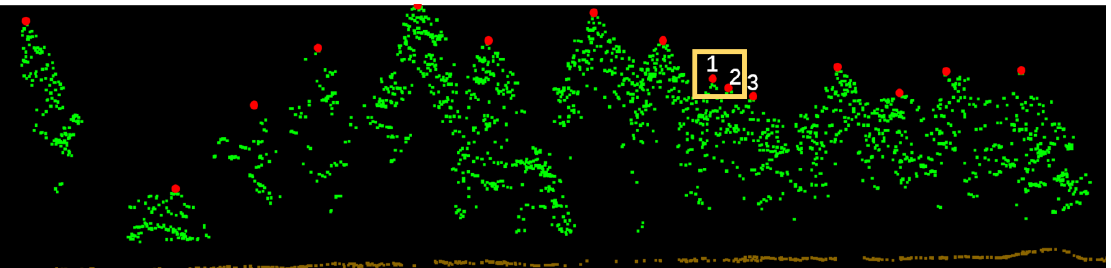
Figure 4. The treetop location. Point 1 and 2 belong to one tree.